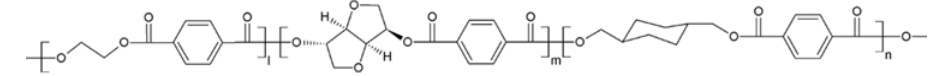
Figure 1. The chemical structure of the terpolyester PEICT; ethylene glycol (EG) (l), isosorbide (ISB) (m), and 1,4-cyclohexane dimethanol (CHDM) (n). Reproduced from Ref. [17] with permission from American Chemical Society.